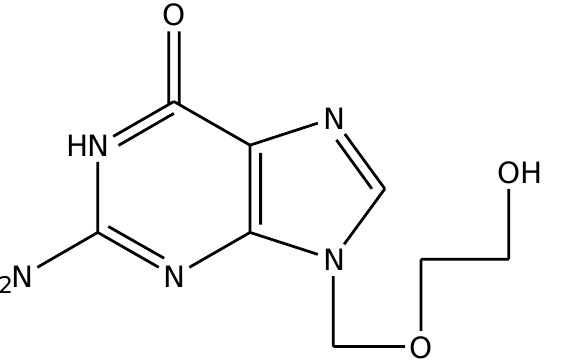
Figure 1. Chemical structure of ACV with weak acidic and basic functional groups.